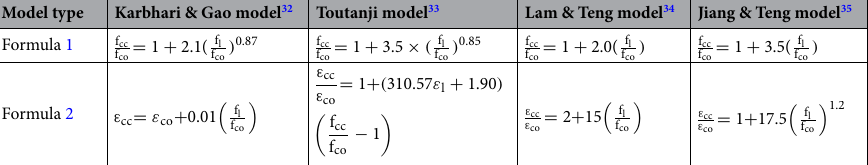
Table 6. FRP ultimate stress–strain model. f cc is the compressive strength of the FRP-confined concrete specimen; f co is the compressive strength of the unconfined concrete specimen; f l is the lateral confined strength provided by FRP; ε cc is the limit point strain corresponding to the FRP-confined concrete; ε co is the unconfined concrete The limit point strain corresponding to the unconfined